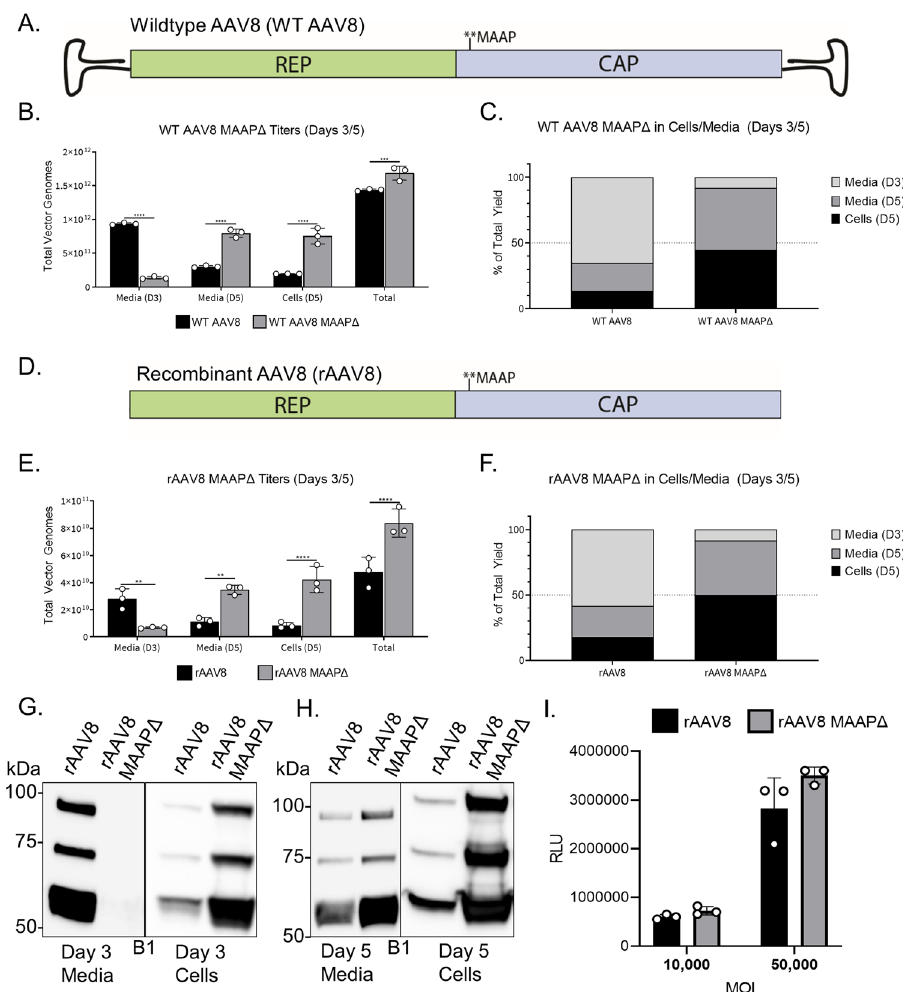
Fig. 2 Ablation of MAAP expression results in a signi fi cant delay in the extracellular secretion of wildtype and recombinant AAV8 particles. A Schematic of WT AAV8 MAAP Δ mutant. B AAV8 ssCBA-Luc vectors produced with WT Cap or MAAP Δ Cap. Total vector genomes collected from